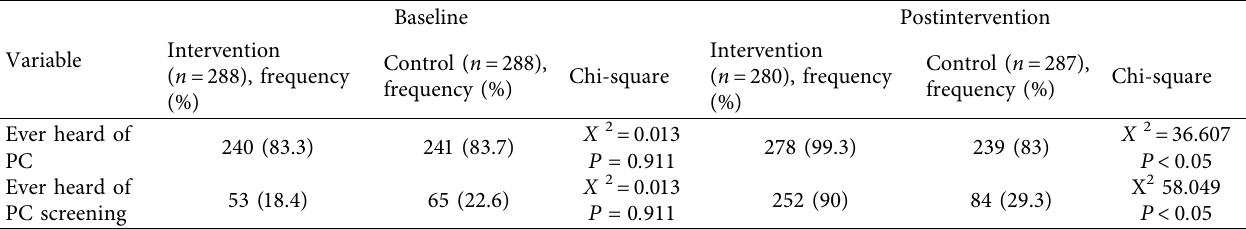
Table 3: Participants awareness on prostate cancer at baseline and postintervention.